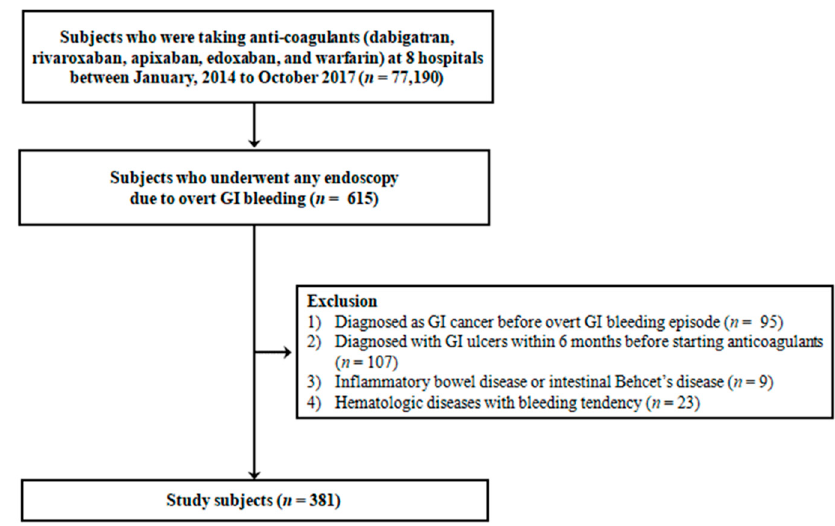
Figure 1. Flow diagram. A total of 615 patients who underwent any endoscopy due to overt GI bleeding were enrolled from eight large-volume university hospitals. Of these, 234 patients were excluded, and 381 patients were enrolled for analysis.